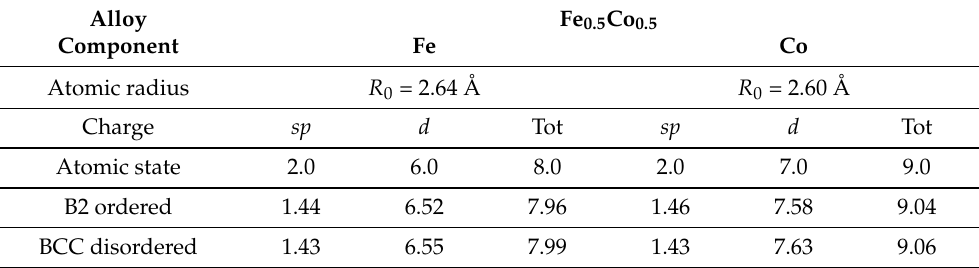
Table 1. Charge redistribution upon alloying: distribution for the ordered B2 and disordered body- centered cubic (BCC) structures for the 50-50 FeCo alloy. The charge is given in units of electronic charge e